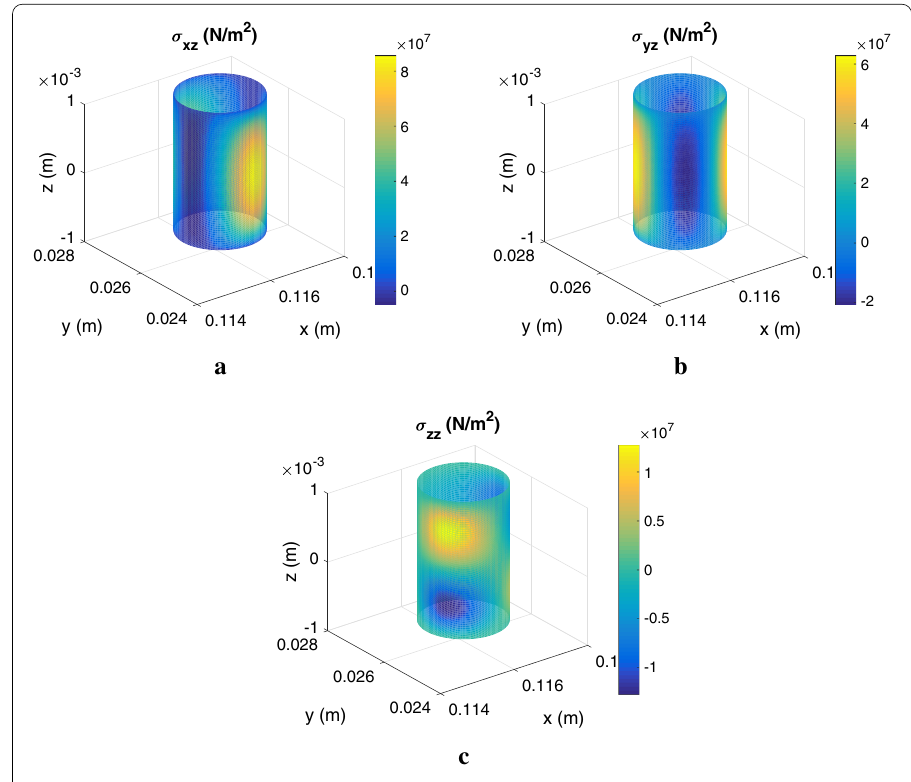
Fig. 9 Out-of-plane components of the stress tensor around the hole